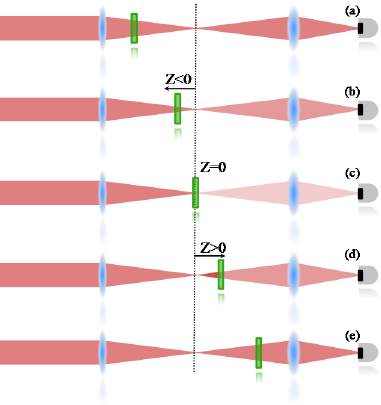
Figure 5. Schematic representation of the transmittance changes as the sample is translated through the focal plane of a focused Gaussian beam. In (a) and (e), sample is far from the focus and there is no nonlinear absorption. For (b) and (d), the sample is close to the focal plane, at this region the intensity may induce weak nonlinear absorption. At Z = 0 (c), the nonlinear absorption effect is the maximum achieved.